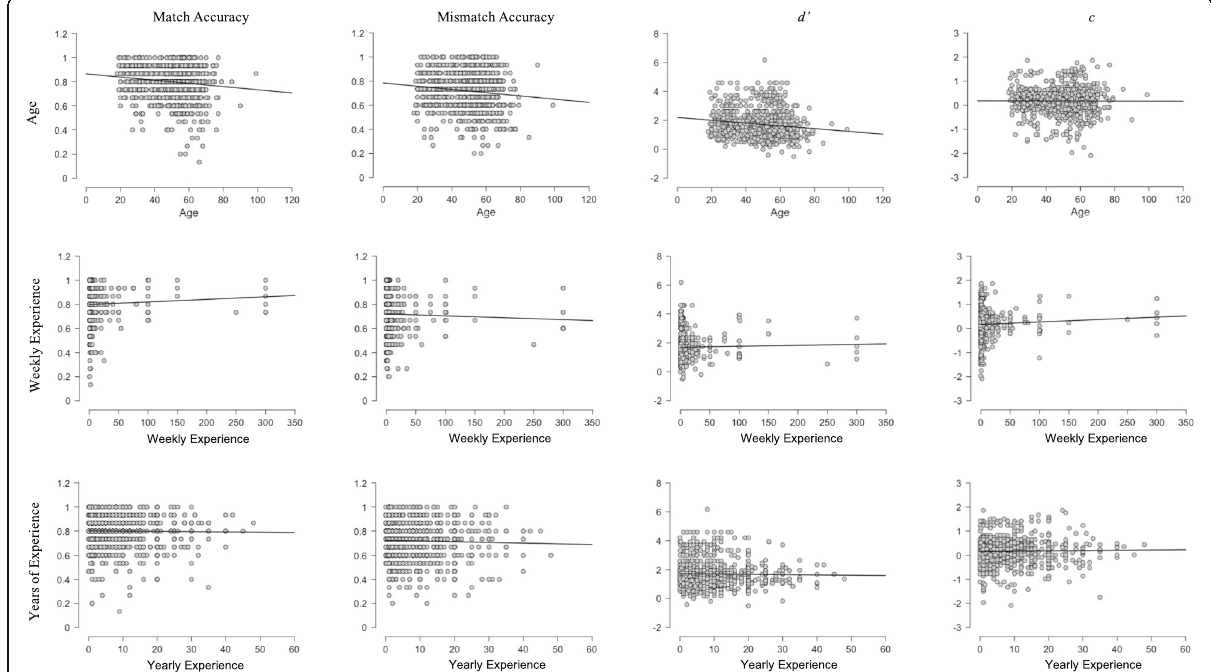
Fig. 3 Scatterplots of the correlations between performance metrics (identified by the columns) and individual differences measures (identified by the rows). Corresponding sequential analyses showing the strength of evidence can be found in the